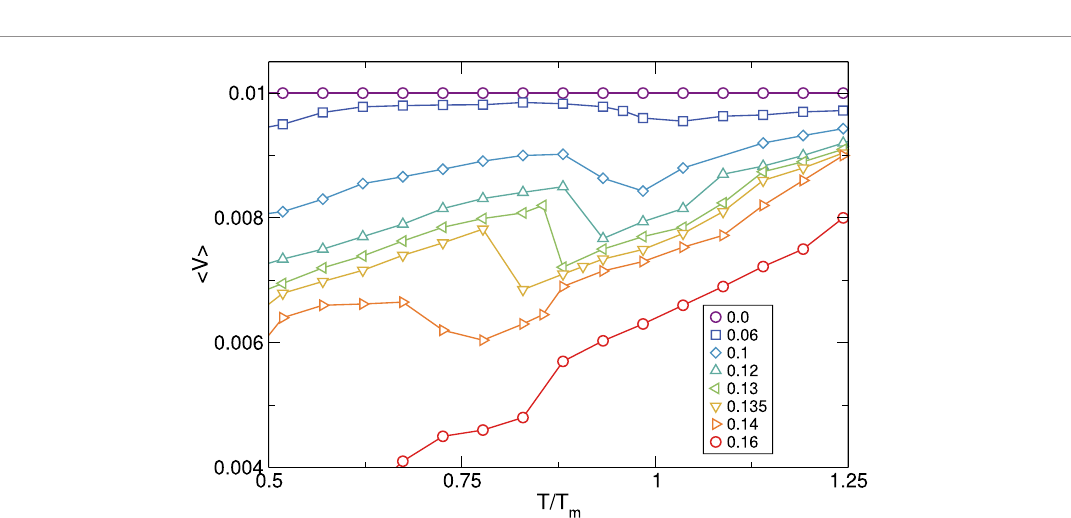
Figure 5. A blowup of the plot of ⟨ V ⟩ vs T / T m in figure 4(b) for the system in figure 2 with n p = 0 . 25 at σ = 0.0, 0.06, 0.1, 0.12, 0.13, 0.135, 0.14, and 0.16, from top to bottom, showing that the velocity drops across the thermal disordering